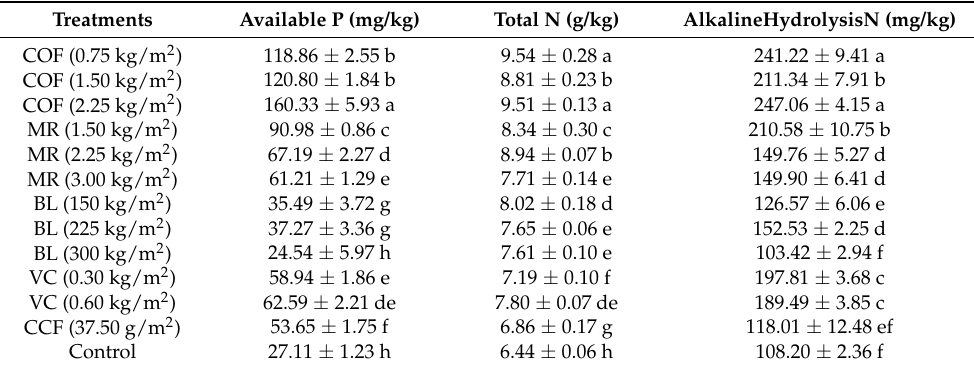
Table 3. Effect of different biological organic fertilizers and chemical fertilizers on the available P, total N, and alkaline hydrolysis N in new reclamation